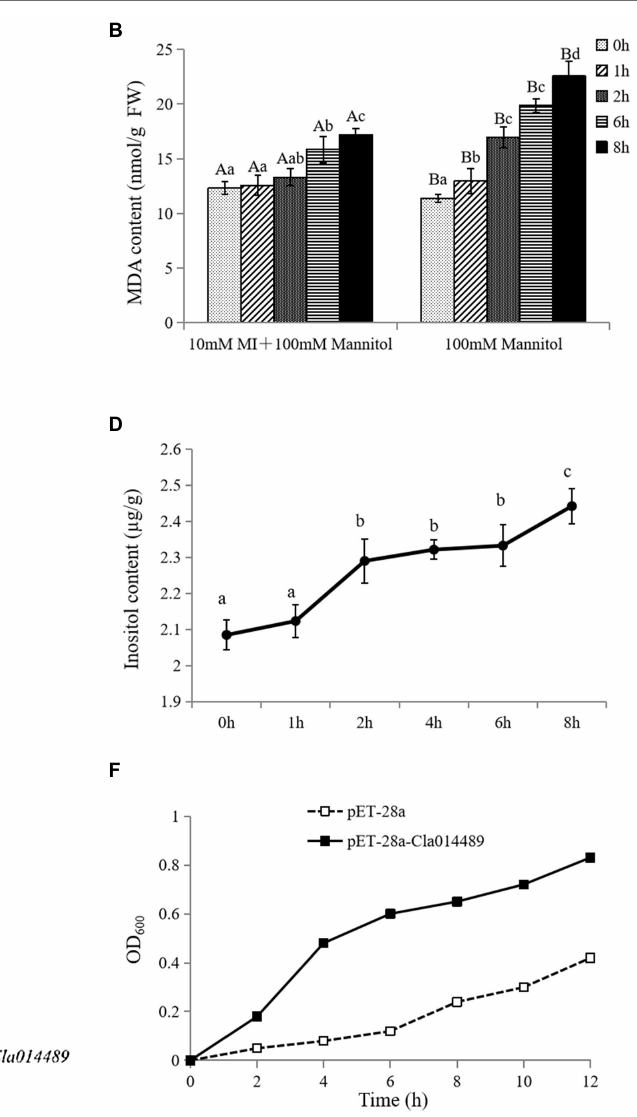
FIGURE 6 | Regulation of osmotic stress by exogenous inositol in watermelon cells and analysis of Cla014489 prokaryotic expression. (A) Effect of exogenous inositol on the growth of watermelon cells under osmotic stress. (B) Effect of exogenous inositol on the MDA content of watermelon cells under osmotic stress. (C) The expression of ClMIPS in response to osmotic stress. (D) Inositol accumulation in watermelon cells under osmotic stress. (E) Droplet plate experiment of recombinant strain pET-28a- Cla014489 and control strain pET-28a under osmotic stress. (F) Time course of growth of the recombinant strain pET-28a- Cla014489 and the control strain (pET-28a) under 600 mmol/l mannitol. Different uppercase and lowercase letters mean differences at p < 0.05 and p < 0.01 levels. Values are means ± SD of three biological replicates. * Indicates significantly difference ( p < 0.05) between the data point and 0 h data